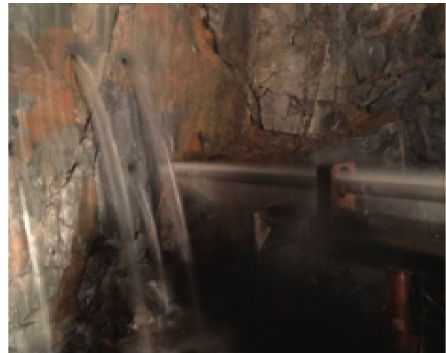
Figure 11: Water gushing during advanced